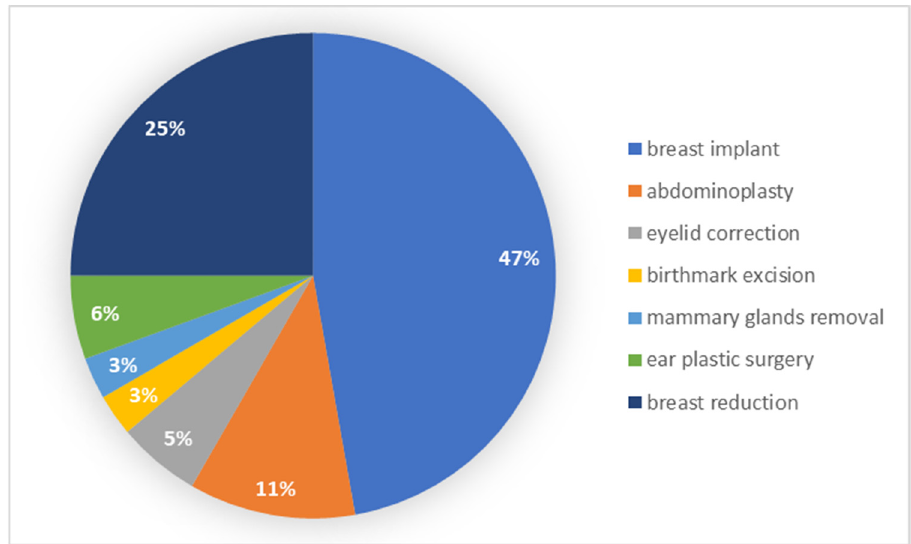
Figure 3. Types of procedures performed by patients with secondary education.